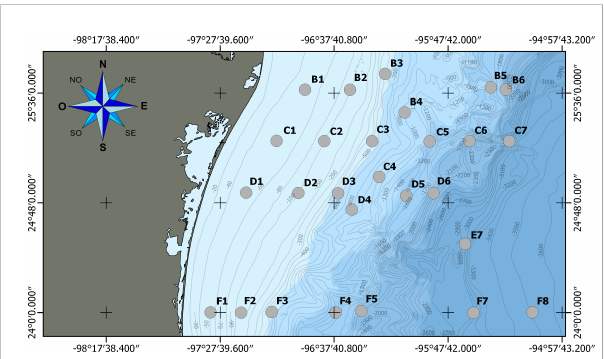
FIGURE 1 Sampling sites in the Gulf of Mexico. Region of study, located from 25.74° to 24° North latitude and from -97.53° to -95.18° West longitude, with the 27 sampling sites distributed in four perpendicular transects (B, C, D, and F) to the Tamaulipas coast that were settled along a bathymetric gradient (43-3573 m). Black crosses indicate the intersection between coordinates. Gray lines indicate isobaths.